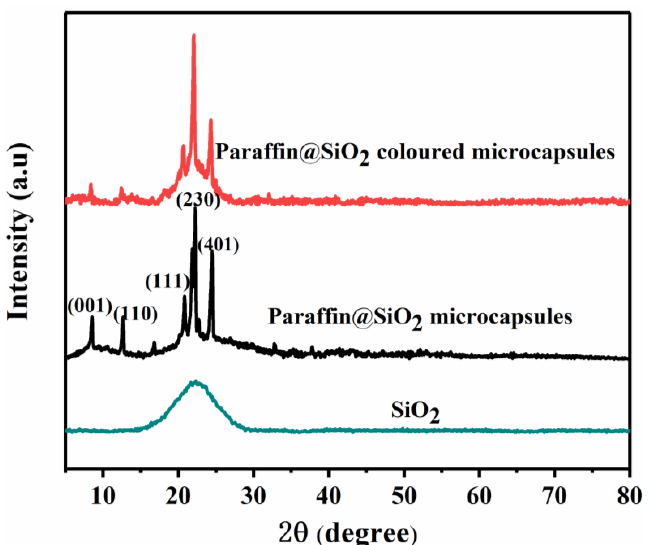
Figure 6. XRD patterns of the paraffin@SiO 2 microcapsules, the paraffin@SiO 2 colored microcapsules, and SiO 2 nanoparticles.